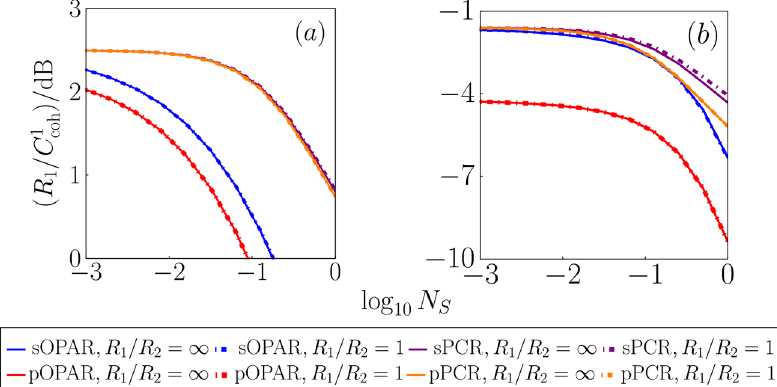
Fig. 9 Receiver rates versus signal brightness. The dependence on source brightness N S,1 = N S,2 = N S of the EA advantage of the four receivers for two-sender MAC communication under the scenario of: a microwave domain η = 1/2, τ = 0.01, N B = 20; b long wavelength infrared domain η 1 = η 2 = 1/2, τ = 0.001, N B = 0.1. In the legend s, p refer to “ serial ” and “ parallel ” , respectively. The number of modes N R is τ N = 0.1 for sender i = 1, 2. We plot R = ∞ (solid) and R = 1 (dot- fi xed such that the SNR N R S / N B 1 for sender 1 under conditions R 1 / R 2 1 / R 2 dashed). Note that R 1 / R 2 = 0, ∞ are equivalent up to a swap due to the symmetry between the two senders; and for given R 1 / R 2 , R 2 = C 2 . ¼ R 1 = C 1 coh coh